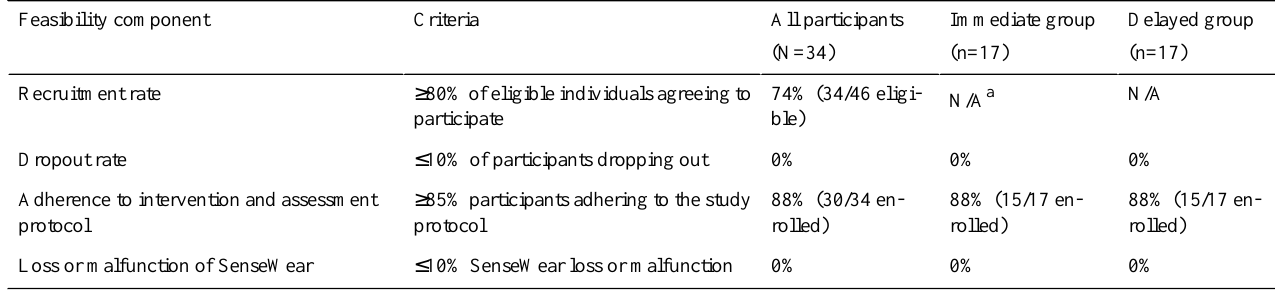
Table 2. Feasibility